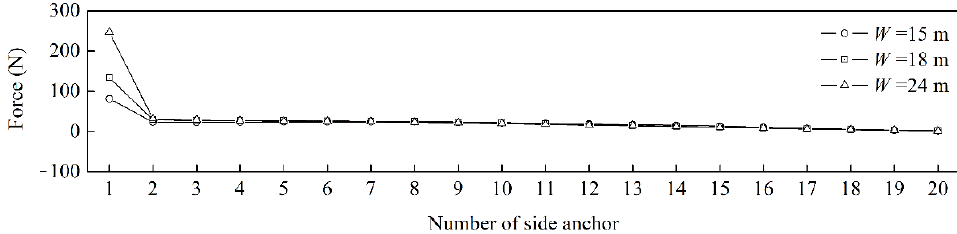
Figure 11. Maximum tension force on the side moorings for different trash-blocking net widths.